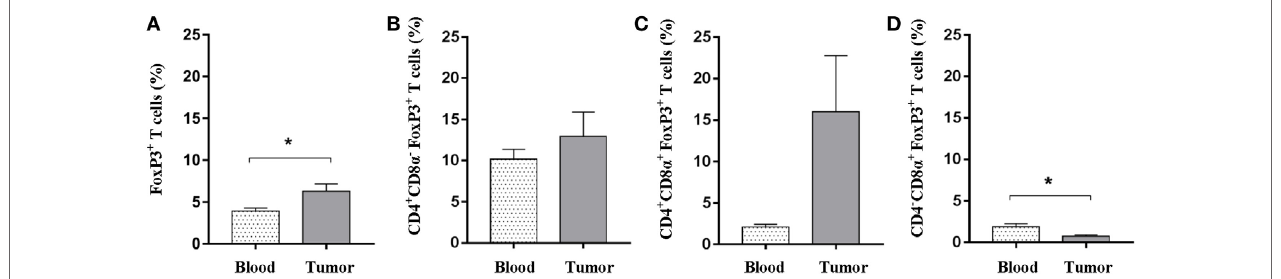
FigUre 5 | Oncopig tumors display increased levels of FOXP3 + T cells. Oncopigs were subcutaneously injected with AdCre. Peripheral blood and tumor samples were harvested 7–21 days post injection and analyzed for intracellular expression of FOXP3 by flow cytometry. Cells were pre-gated on viable, single lymphocytes. (a) Percentage of FOXP3 + cells in live, CD3 + -gated cells. (B) Percentage of FOXP3 + cells in live, CD4 + CD8 α − gated T cells. (c) Percentage of FOXP3 + cells in live, CD4 + CD8 α + -gated T cells. (D) Percentage of FOXP3 + cells in live, CD4 − CD8 α + -gated T cells. All bars represent mean values ± SEM, and data are from one experiment ( n = 5). Statistical evaluations were performed by paired Student’s t -test (* P <